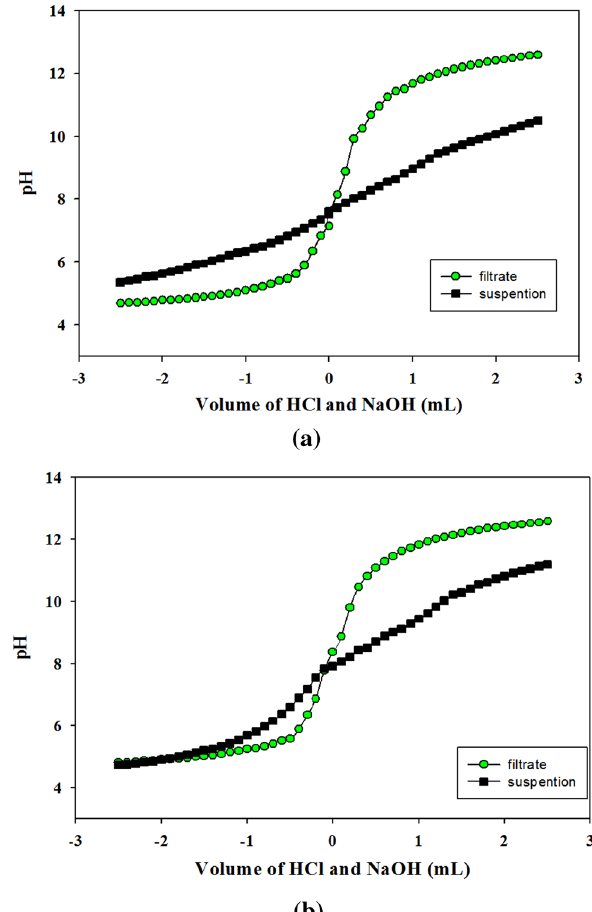
Fig. 1 a A pH metric titration curve of coconut coir dust in 0.01